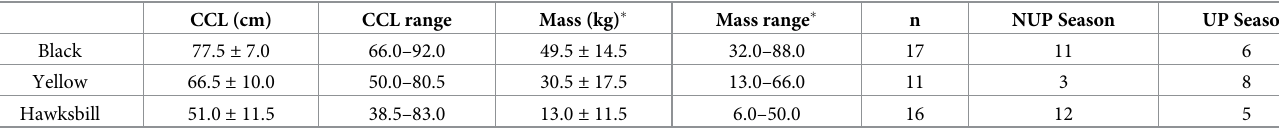
Morphological measurements of sea turtles sampled including curved carapace length (CCL) in cm, and body mass in kg, with values representing mean ± standard deviation and ranges. Non-upwelling (NUP) season (April–October) represent the number of turtles captured during the non-upwelling season, while upwelling (UP) season (November–March) represent the number of turtles captured during the upwelling season. Black = black morphotype green turtles, Yellow = yellow morphotype green turtles. � Mass measurements presented for Black n = 16, Yellow n = 7, and Hawksbill n = 16.